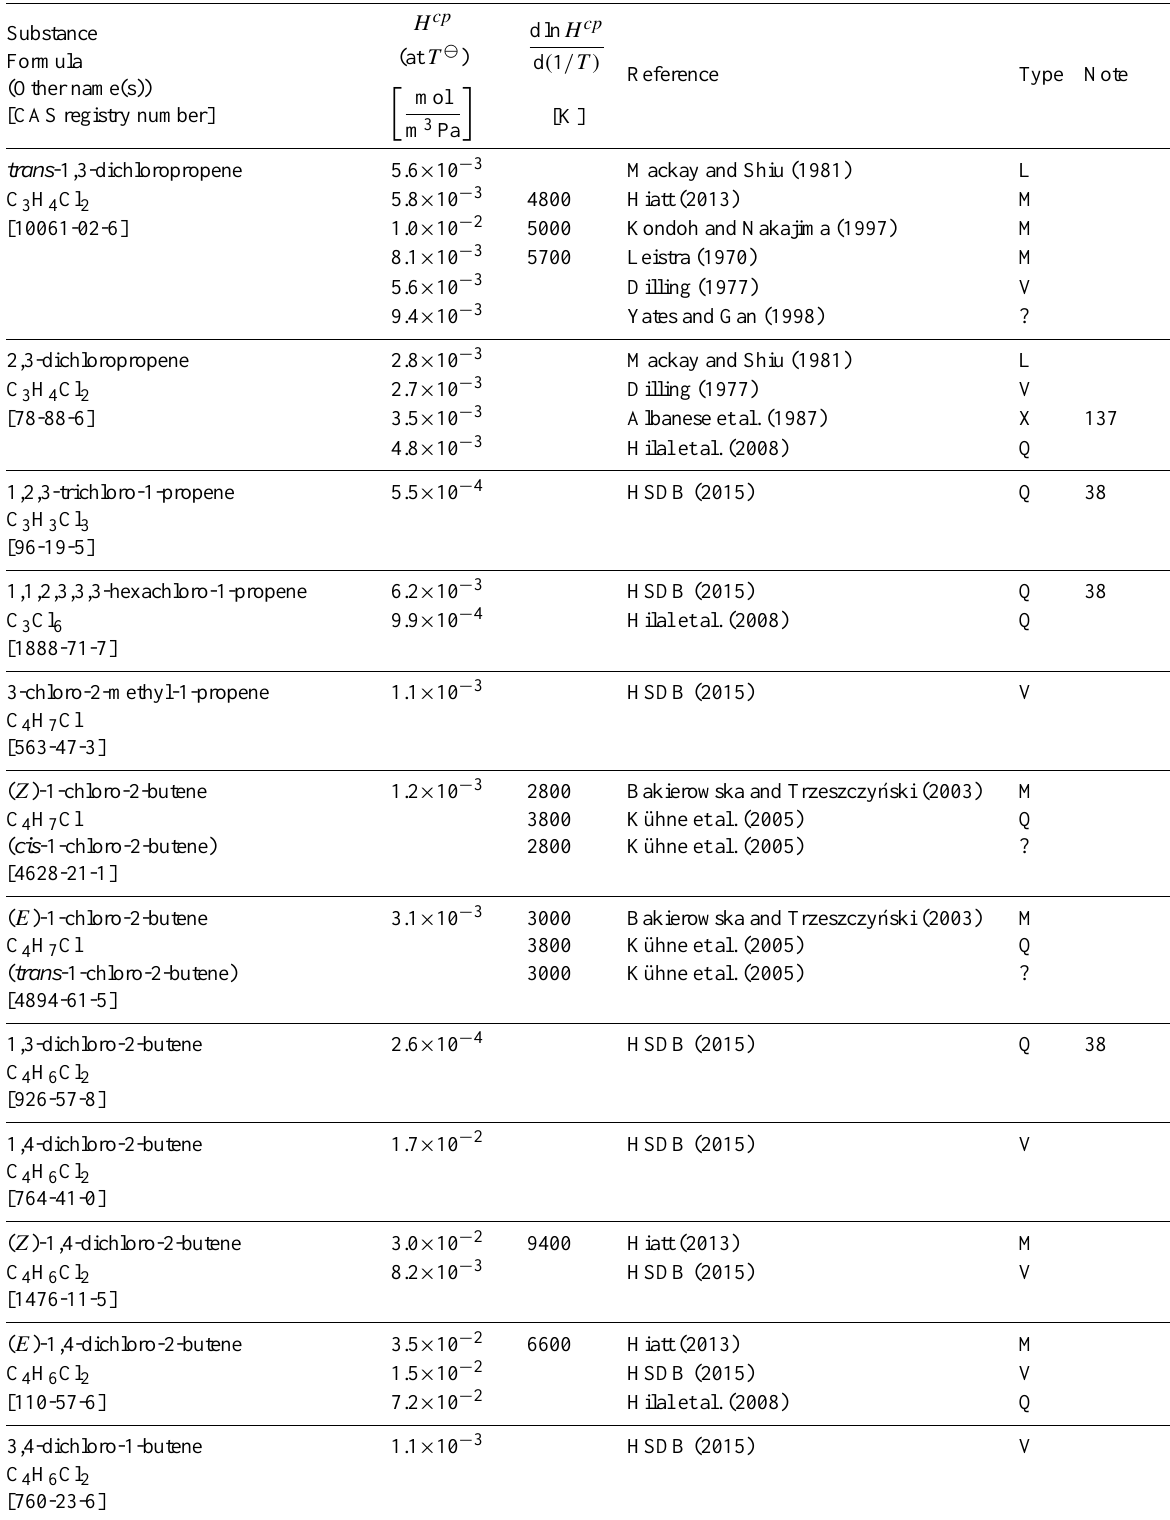
Table 6: Henry’s law constants for water as solvent